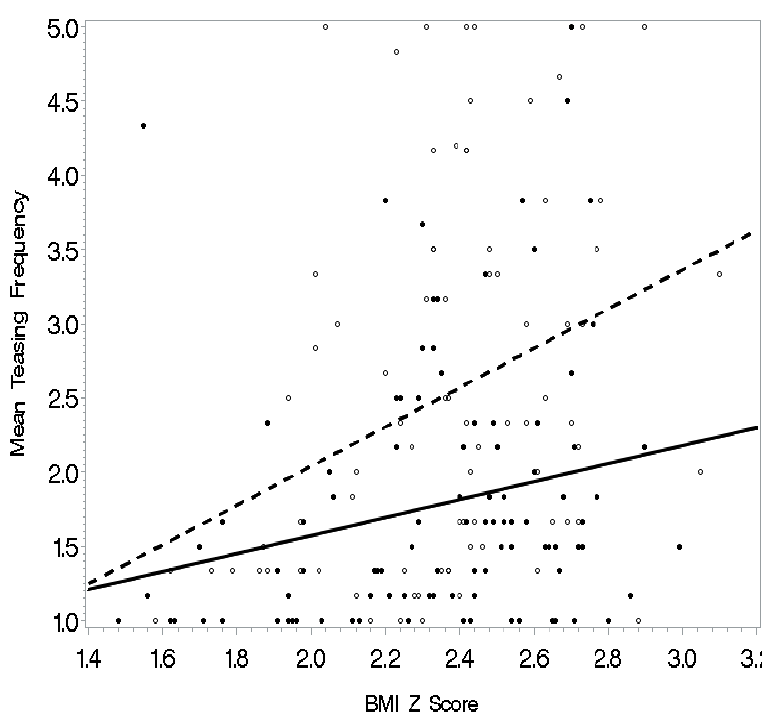
Figure 2. Awareness of society’s attitudes toward appearance as a moderator: A minimal relationship existed between BMI z-scores and teasing frequency for those adolescents who were less aware of society’s attitudes toward appearance (solid line); however, the relationship of BMI z-scores with teasing was significant for adolescents with high awareness of societal attitudes toward appearance (dashed line).